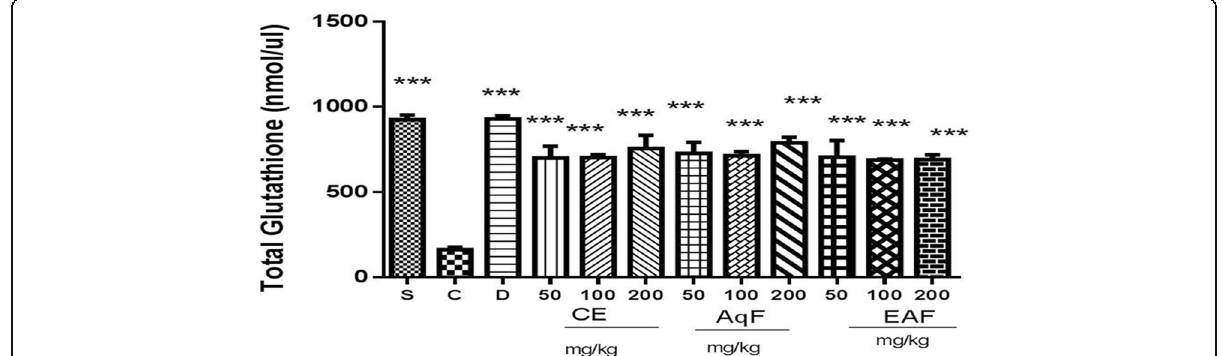
Fig. 4 Effects of the CE and fractions (50, 100 or 200 mg/kg) of E. uniflora Linn on total glutathione levels (nmol/ul) in a carrageenan-induced peritonitis model versus the carrageenan group. The results are expressed as the mean ± standard mean error ( n = 5). An ANOVA test was used to calculate statistical significance, *** p < 0.001 versus the positive control group. S (sham), C (carrageenan), D (diclofenac), CE (crude extract),